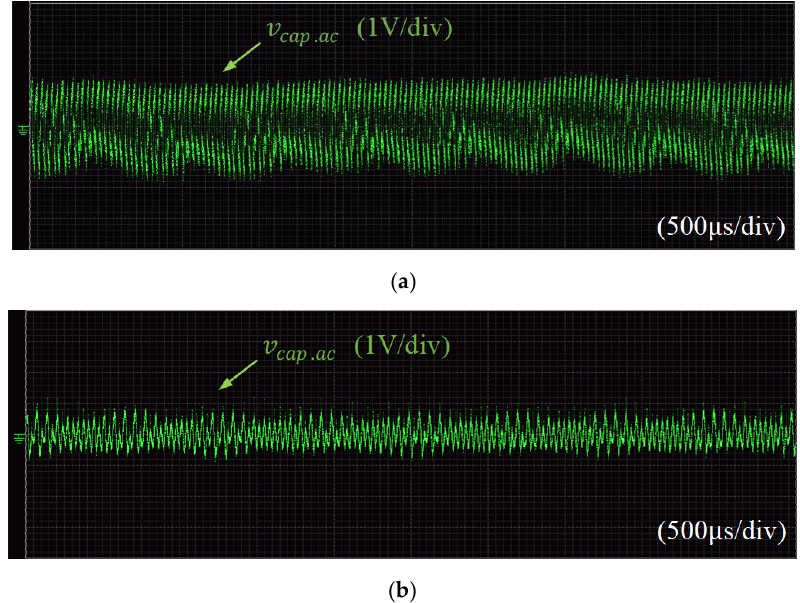
Figure 19. AC component of capacitor voltages (1 V/div, 500 μs/div) from ( a ) the electrolytic capacitor and ( b ) the film capacitor.